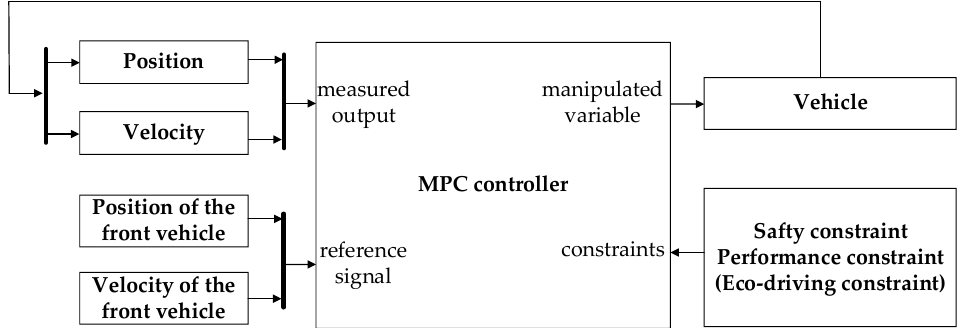
Figure 8. The procedure of the improved MPC strategy. Table 2. The emission coefficients for the MOE of carbon dioxide [30].